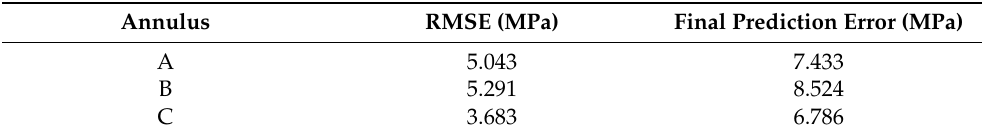
Table 4. The error analysis of simulations using the full-liquid